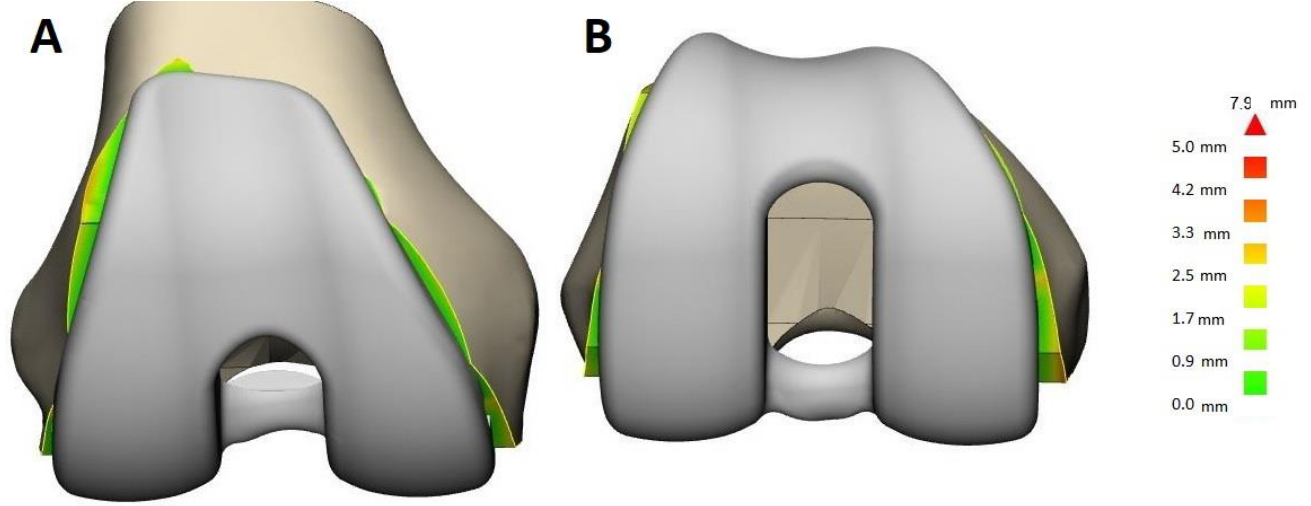
Figure 10. ( A ): Underhang of the femoral component in the frontal view. The underhang is most important on the lateral side of the anterior shield. ( B ): Underhang of the femoral component in the axial view. The underhang is most important on the medial side of the distal cut.